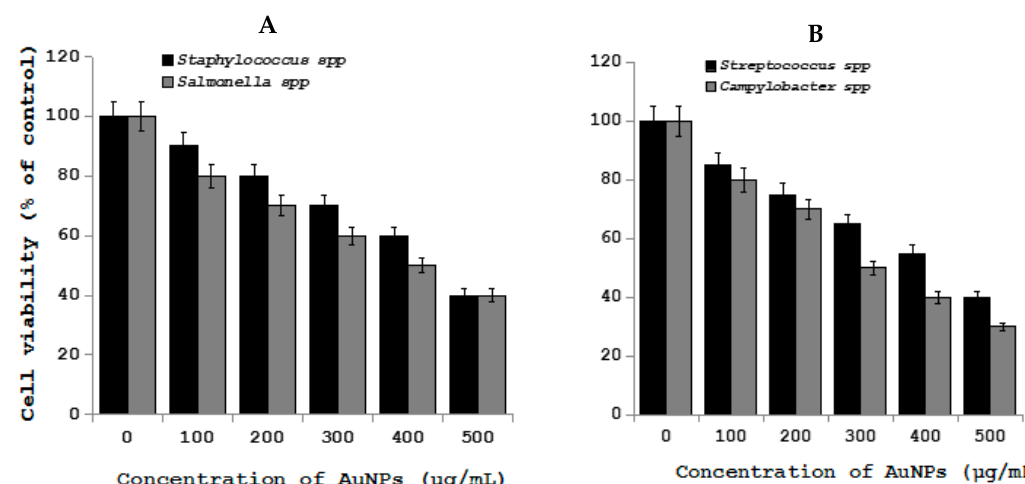
Figure 4. ( A ) TEM images of AuNPs ( B ). Size distribution of AuNPs from TEM images. TEM images of several fields were used to measure AuNPs particle size; micrographs (left panels); and, size distributions based on TEM images (right panels) of AuNPs ranging from 2 nm to 12 nm.